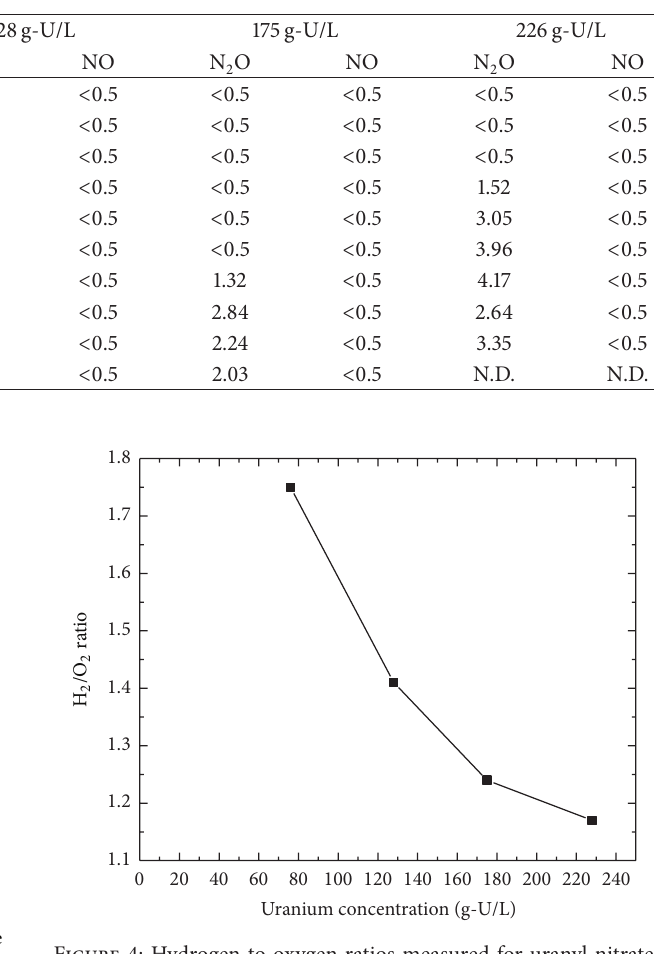
Figure 4: Hydrogen to oxygen ratios measured for uranyl nitrate solutions during irradiation tests at the Van de